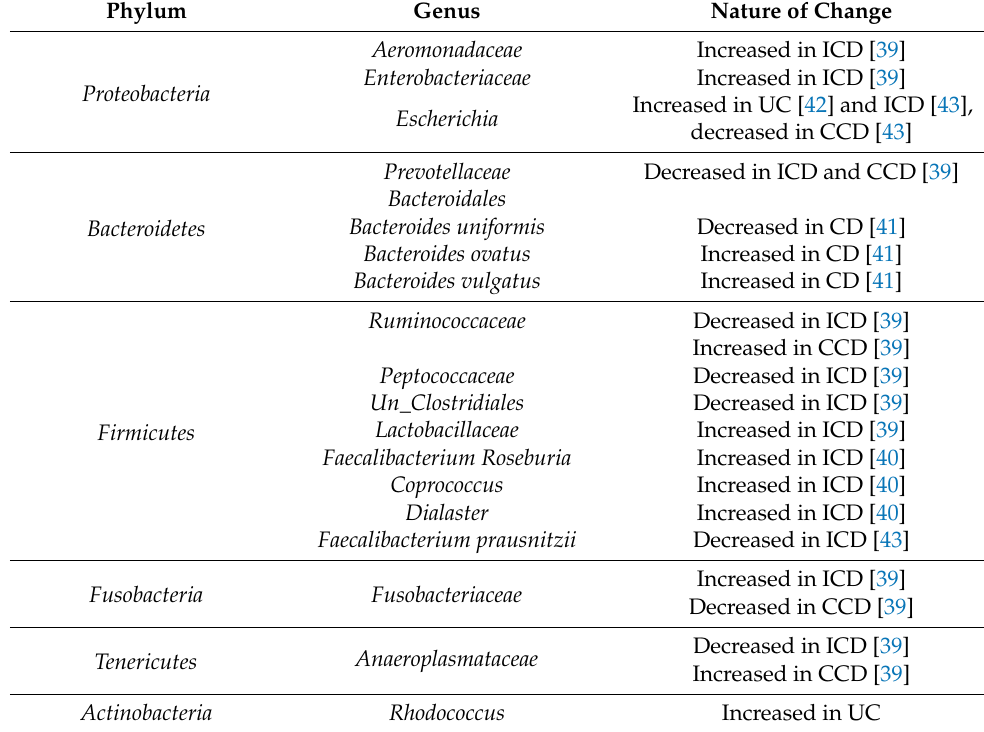
Table 2. Summarising the changes in bacterial population in twin studies.